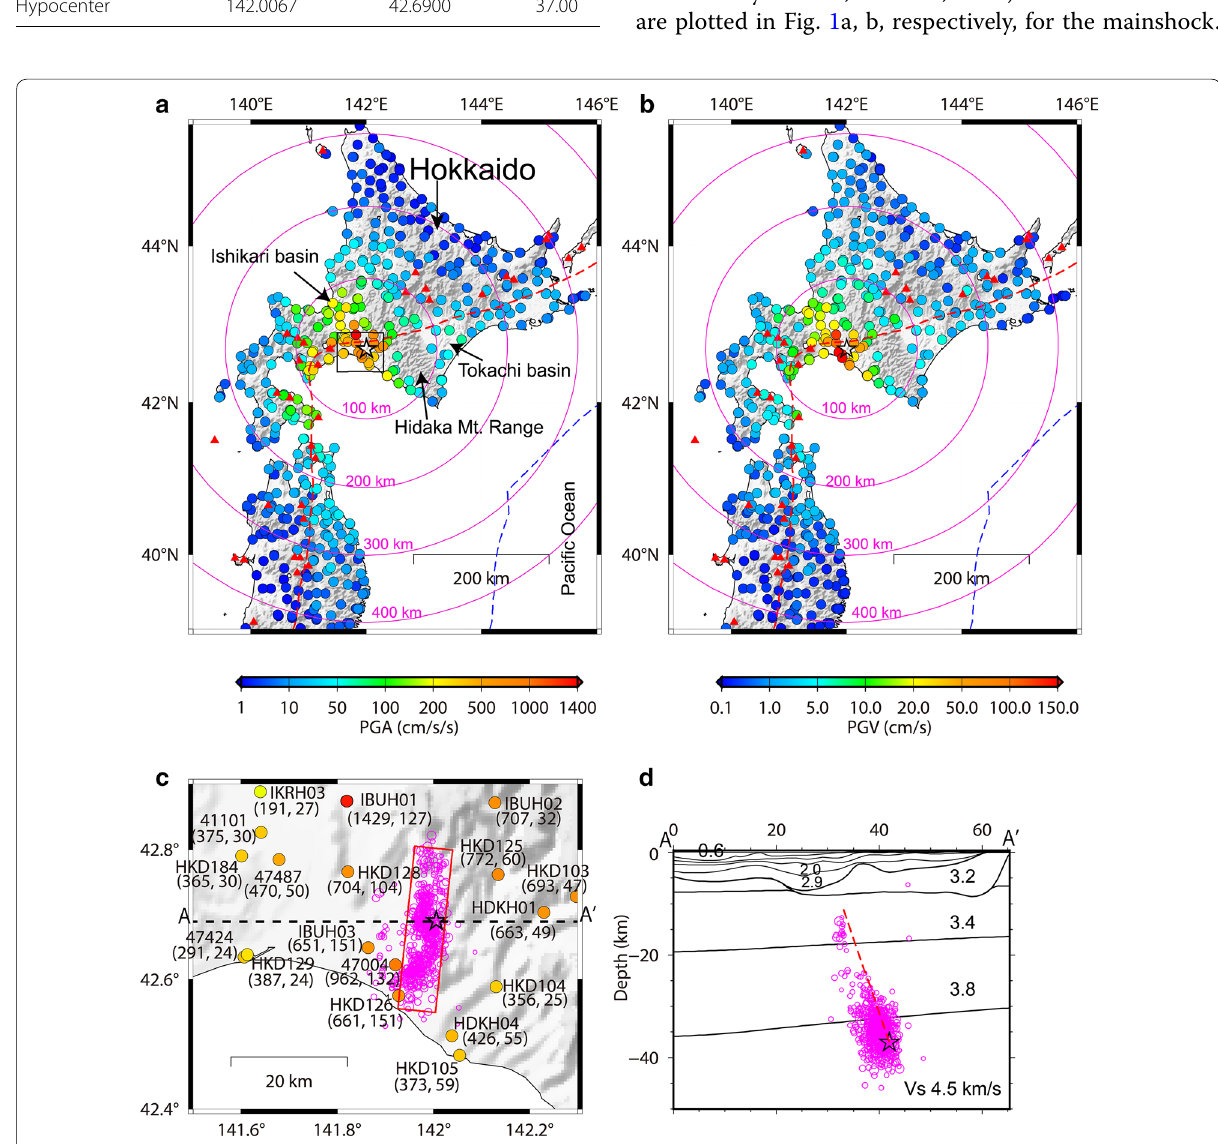
Fig. 1 a , b Show the plots of observed horizontal vector PGAs and PGVs, respectively. A star denotes epicenter of the mainshock. Triangles and dashed red line denote active volcanoes and volcanic front line, respectively. c Enlarged view of the rectangular area drawn around the epicenter in a with additional information. Numbers in parentheses denote the values of horizontal vector PGAs (cm/s 2 ) and PGVs (cm/s), respectively, at recording stations color-coded by PGAs. The magenta circles denote aftershocks of Mj 2 for the 9 days after the mainshock. The rectangle denotes ≥ the surface projection of an approximate fault plane. d Vertical section of JIVSM (Japan integrated velocity structure model) along the profile A – A ′ shown in c . A red dashed line denotes the intersection line of the inferred fault plane with the vertical